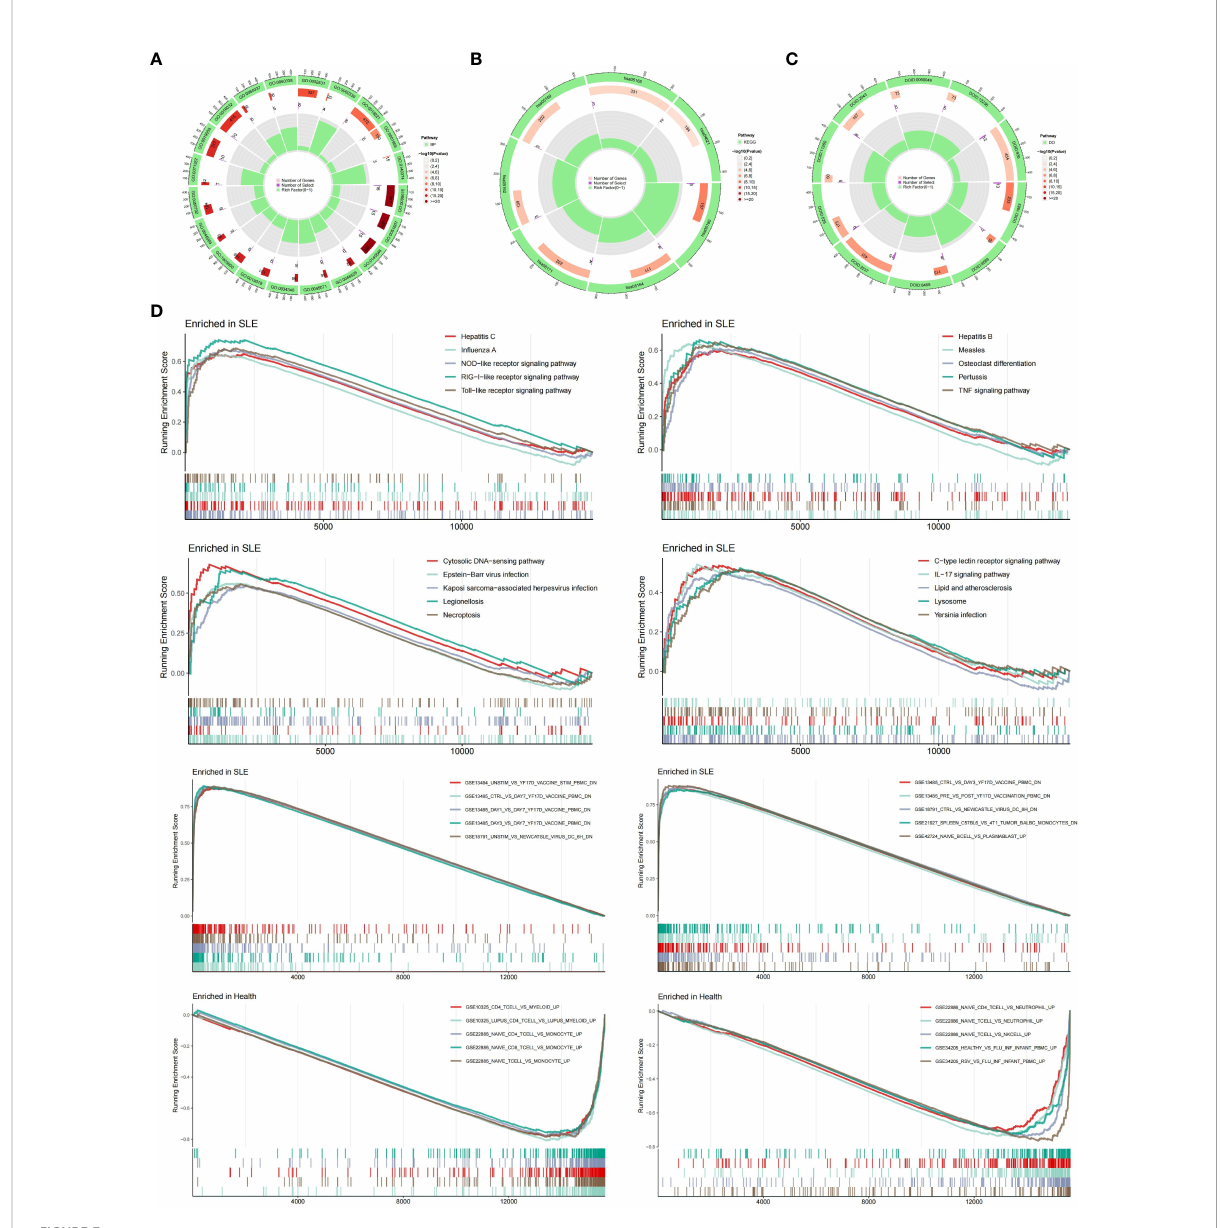
FIGURE 3 Enrichment Analysis. (A) Ring diagram of biological processes analyzed by GO enrichment. (B) Ring diagram of KEGG enrichment analysis. (C) Ring diagram of DO enrichment analysis. (D) About pathway-related and immune-related